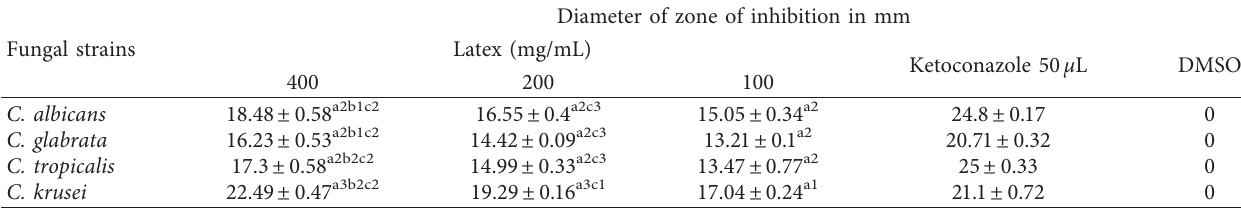
Table 2: Zone of inhibition of the leaf exudate of Aloe megalacantha against Candida species. Fungal strains